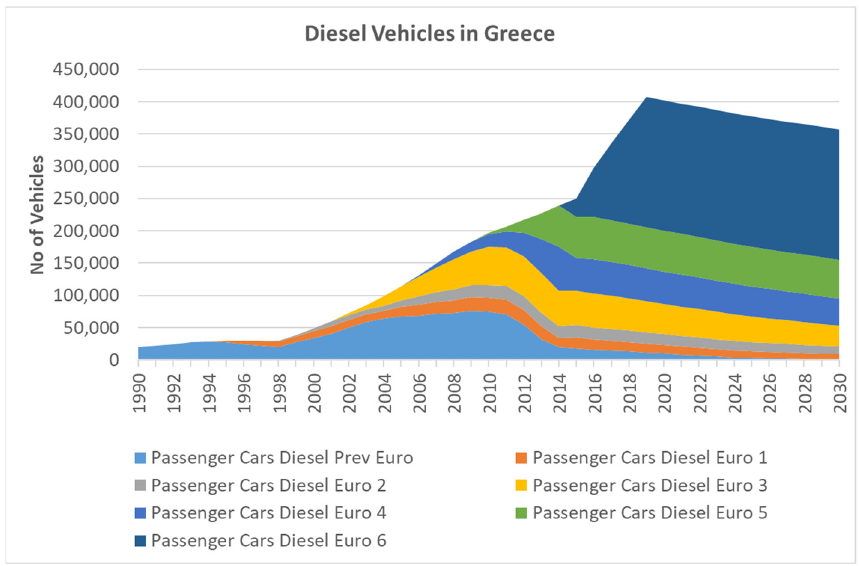
Figure 6. Time-evolution of the fleet size of diesel-powered vehicles in Greece, 1990–2030.